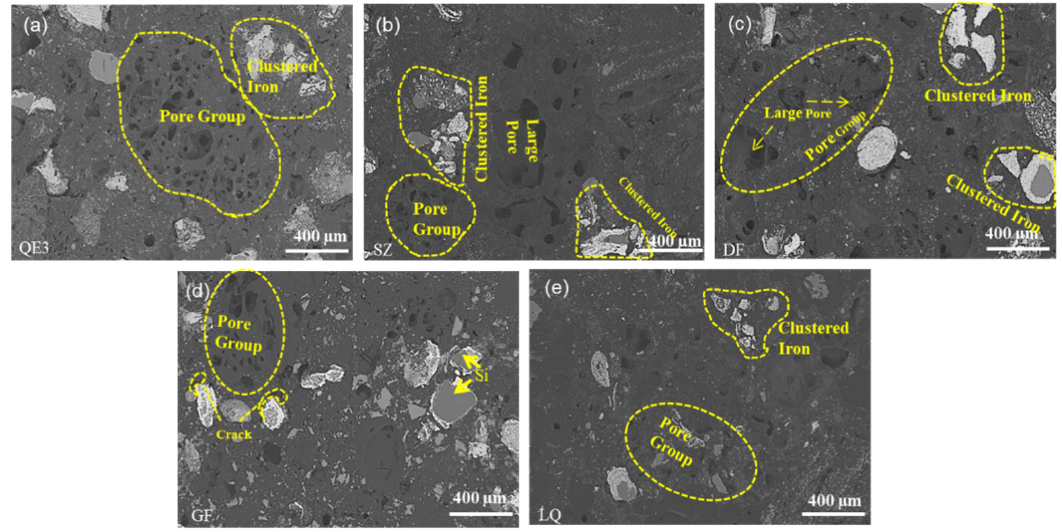
Figure 13. SEM of ferro-coke with different binders: ( a ) 70%QM+30%EX; ( b ) 63%QM+27%EX+10%SZ; ( c ) 63%QM+27%EX+10%DF; ( d )63%QM+27%EX+10%GF, and ( e ) 63%QM+27%EX+10%LQ.